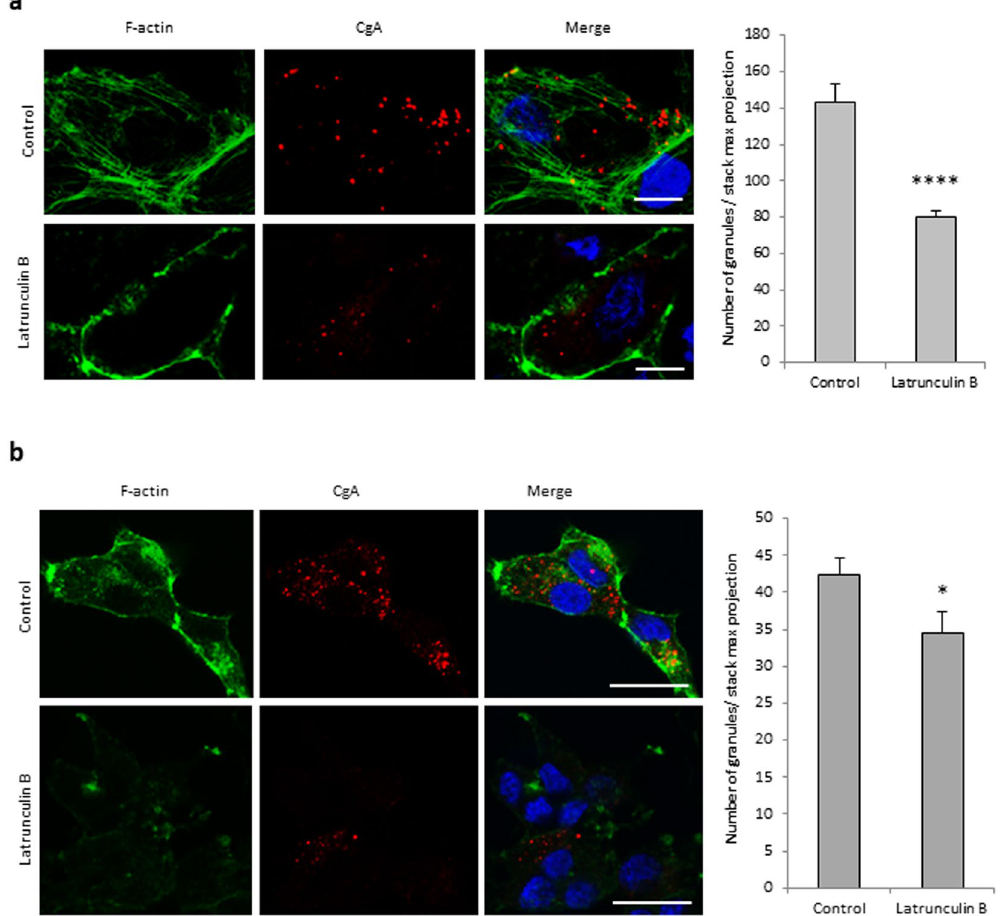
Figure 5. F-actin is required for the biogenesis of secretory granules. COS7-CgA cells ( a ) and PC12 cells ( b ) were treated using DMEM alone (control) or supplemented with latrunculin B. They were labeled with fluorescent phalloidin (F-actin), immunolabeled with anti-CgA antibody and analyzed by confocal microscopy. Projected images of 26 0.3 µ m-thick confocal sections throughout the cells are shown. The scale bar represents 20 µ m. The number of CgA granules in control and treated cells was quantified and expressed as mean + s.e.m. from three independent experiments (n = 30 cells). * P < 0.05, **** P < 0.0001 (Mann-Whitney